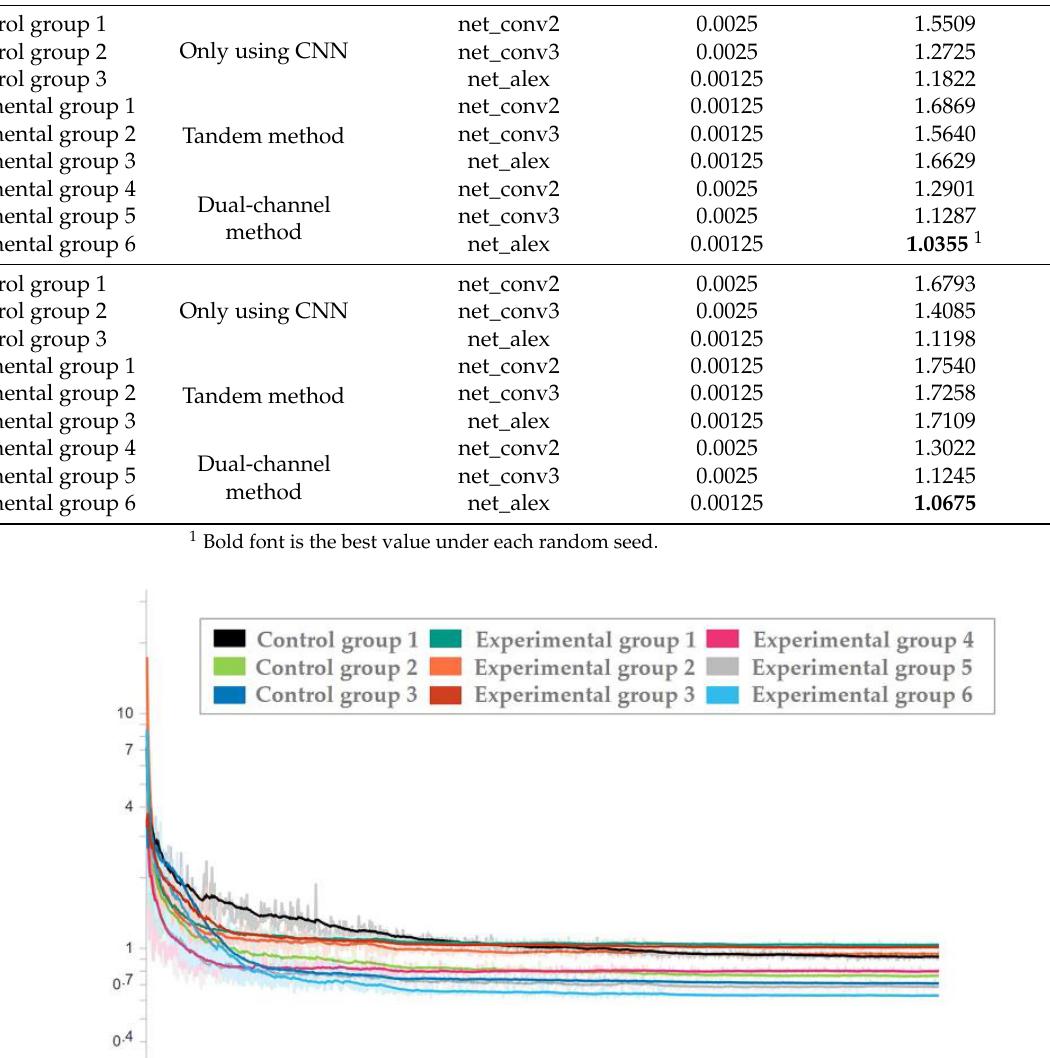
Figure 17. Loss trend of the test set with random seed 1.